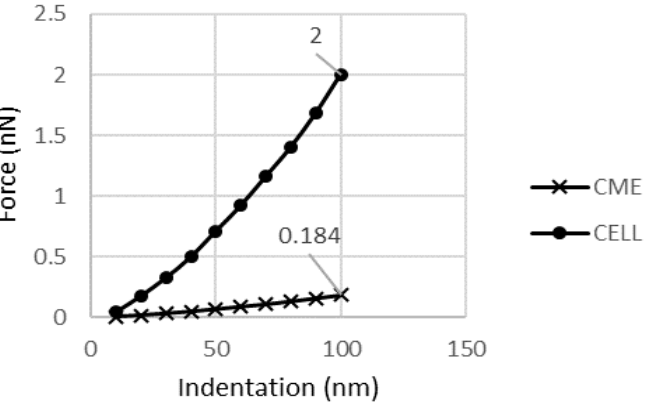
Figure 9. Contribution of the continuous parts to support the reaction force by the cell.